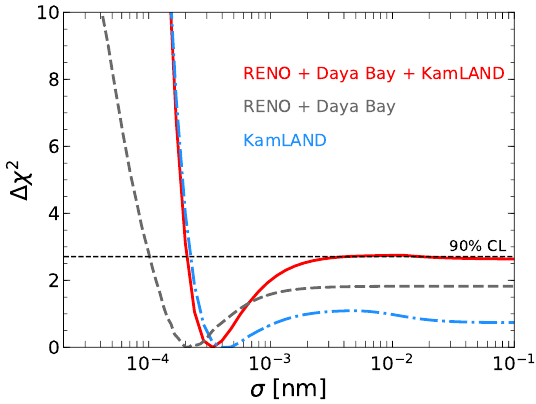
Figure 4 . The reduced χ 2 as a function of σ relative to its minimum value, obtained from the combined analysis of RENO, Daya Bay and KamLAND (red, solid) and from the combined analysis of only short-baseline experiments (grey,